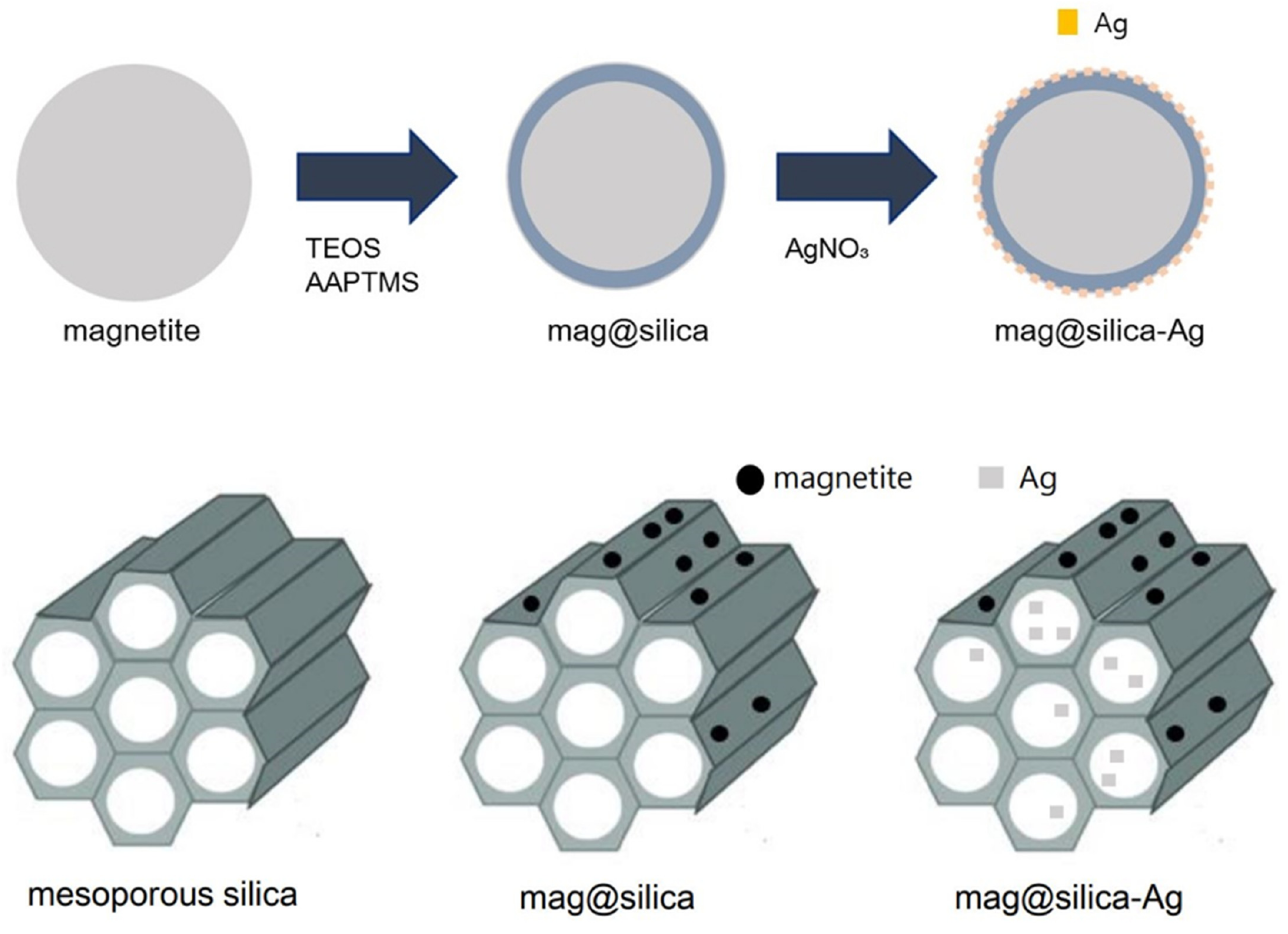
Figure 1. Synthesis of mag@silica-Ag.